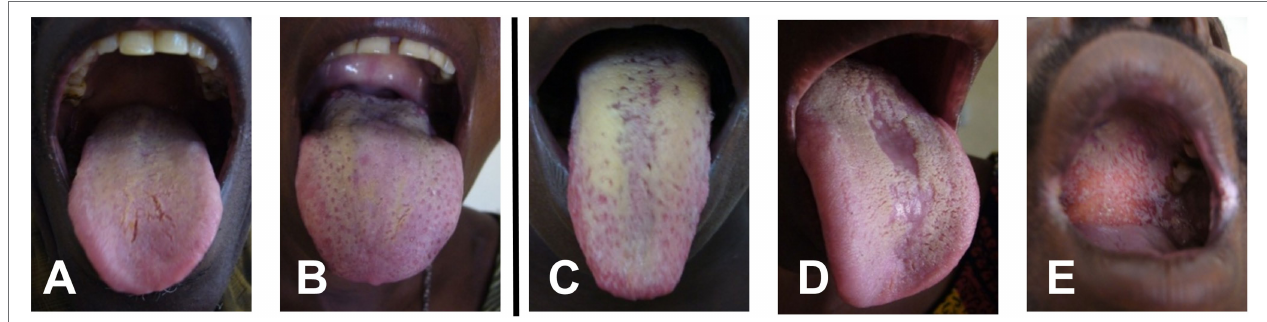
FIGURE 1 | Representative samples of oral symptoms of the tongue and palate within the study group: (A,B) mild symptoms with less than 50% coverage of the tongue by whitish plaque, (C) >50% of tongue surface covered with whitish plaque, (D) median rhomboid glossitis with central atrophy, and (E) involvement of